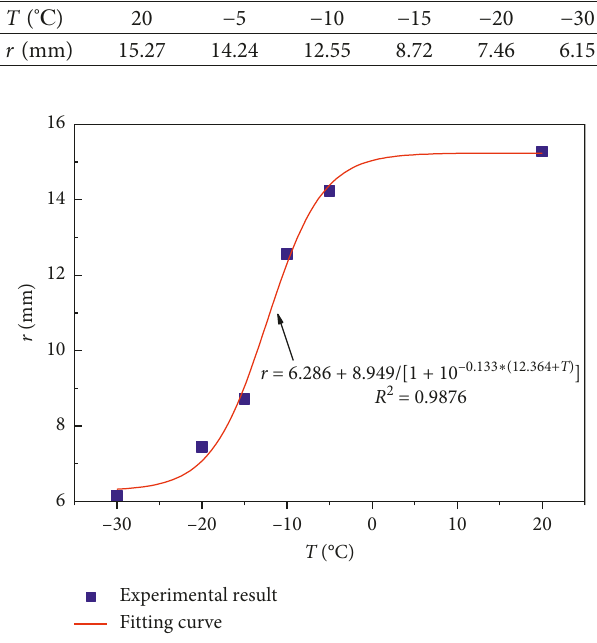
Figure 16: Relationship curve between particle size coefficient and F-T temperatures.